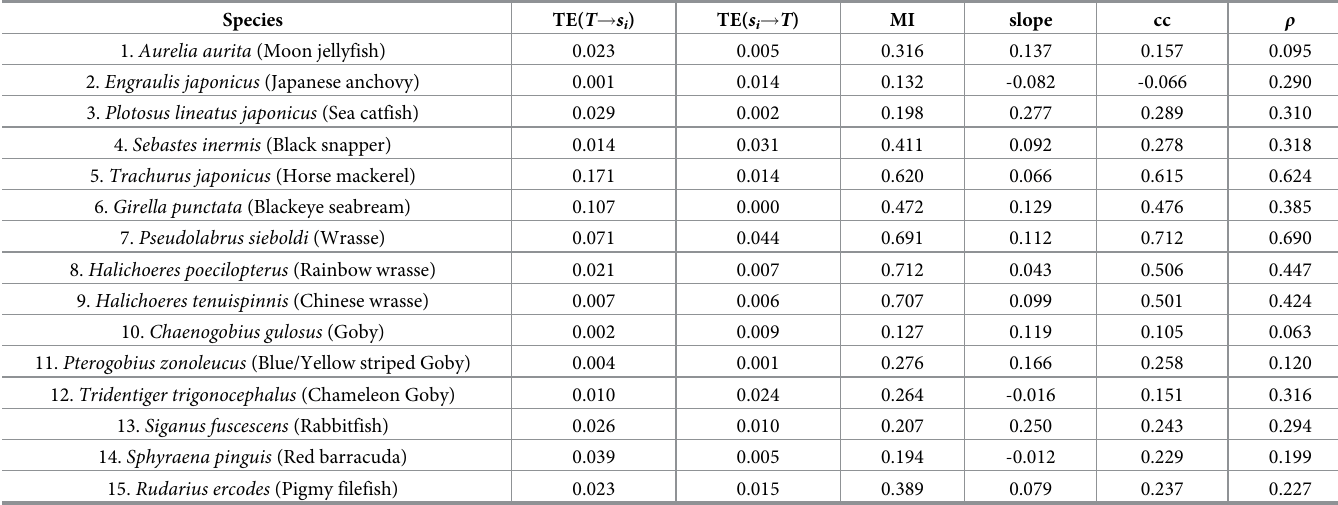
Table 3. Indices measuring the relationship between ST and species